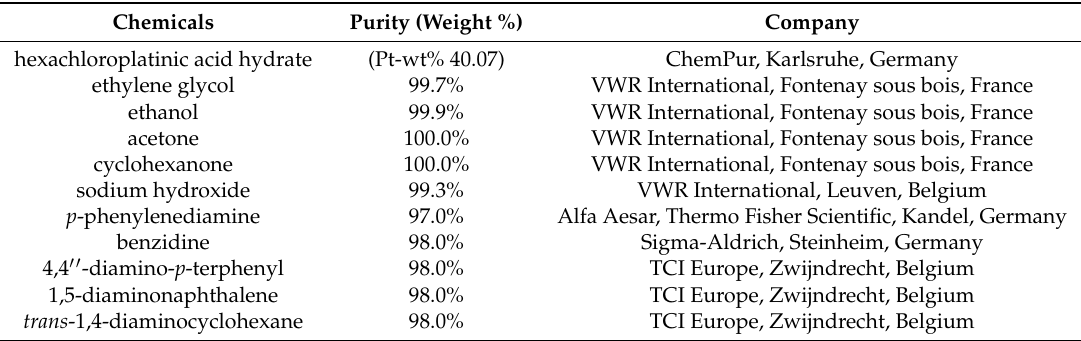
Table 1. List of the chemicals for catalyst